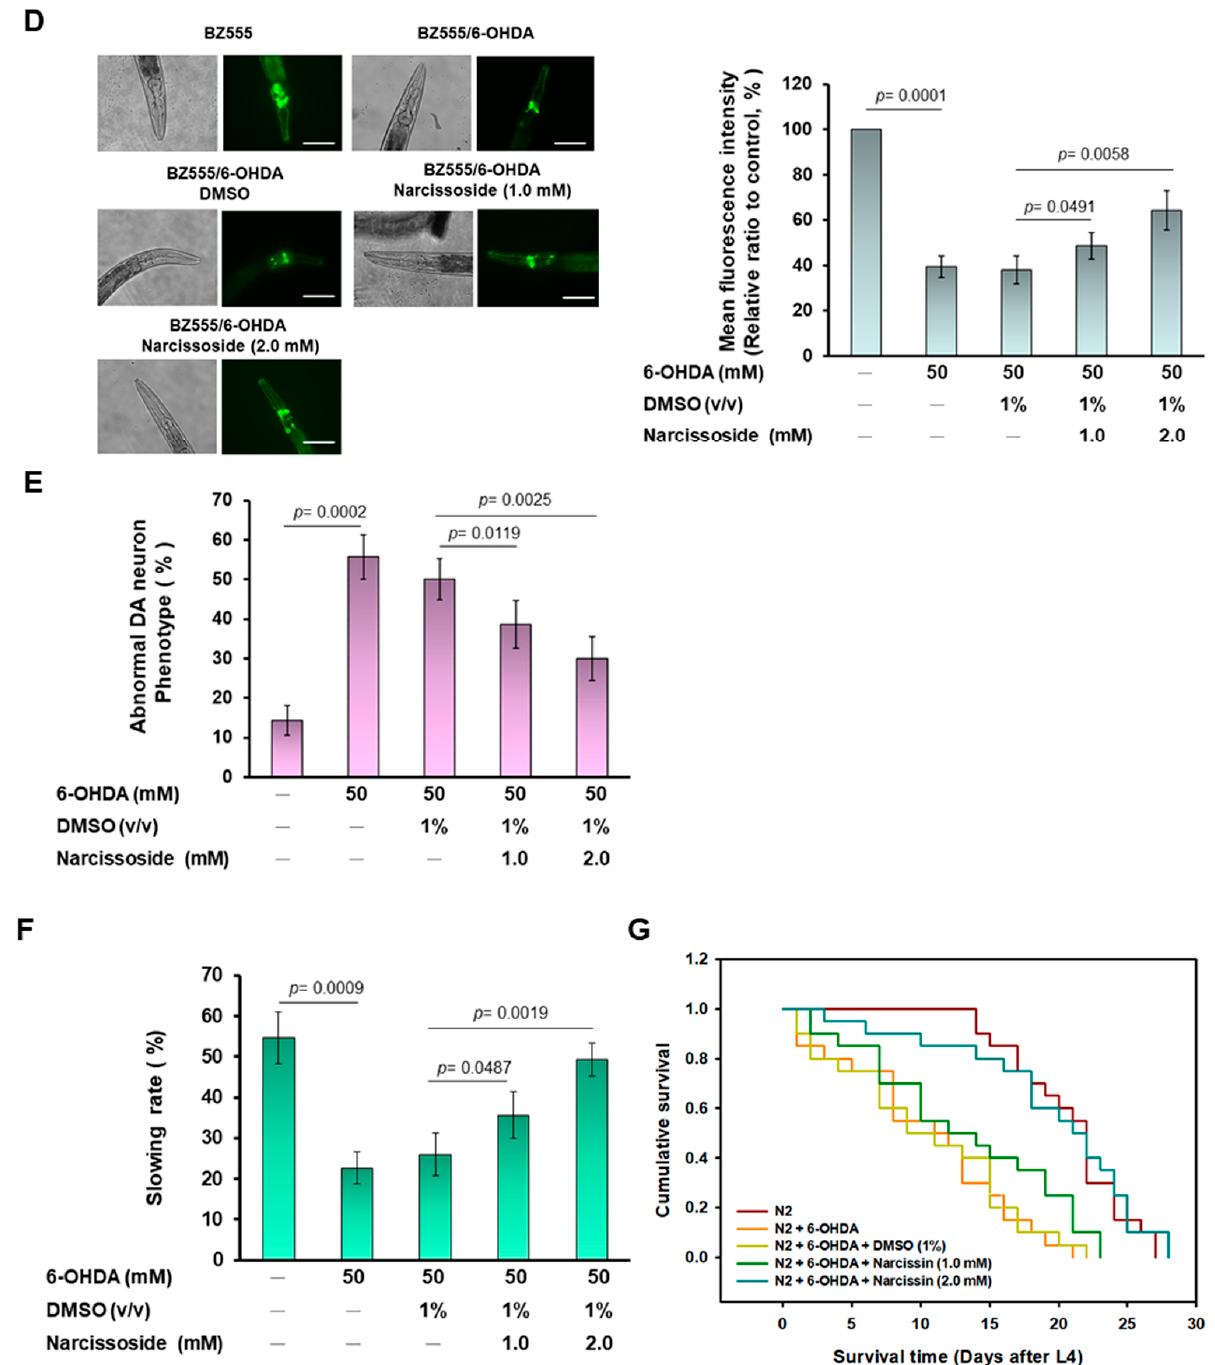
Figure 9. The 6-hydroxydopamine (6-OHDA)-caused dopaminergic (DA) neurons degeneration, food-sensitive behavioral deficits, and shortened lifespan in nematodes were ameliorated by narcissoside (NCS) pretreatment. ( A ) Appropriate concentrations of narcissoside (NCS) to treat nematodes were determined by food clearance assays. In 96-well plates, L1 stage nematodes of N2, BZ555, NL5901, and DA2123 were grown on S medium containing OP50 of E. coli (OD A 595 = 0.6), and a series of dilution NCS concentrations. The plates were placed in an incubator at 20 °C for 6 days, and each well was recorded the OD value daily. ( B , C ) Transfer L1 stage nematodes of BZ555 to culture plates with or without DMSO (1%) and grow to L3 stage, following by exposure to 50 mM 6-OHDA for 1 h. Next, nematodes were transferred to 5-fluorodeoxyuridine (FUDR)-containing culture plates with